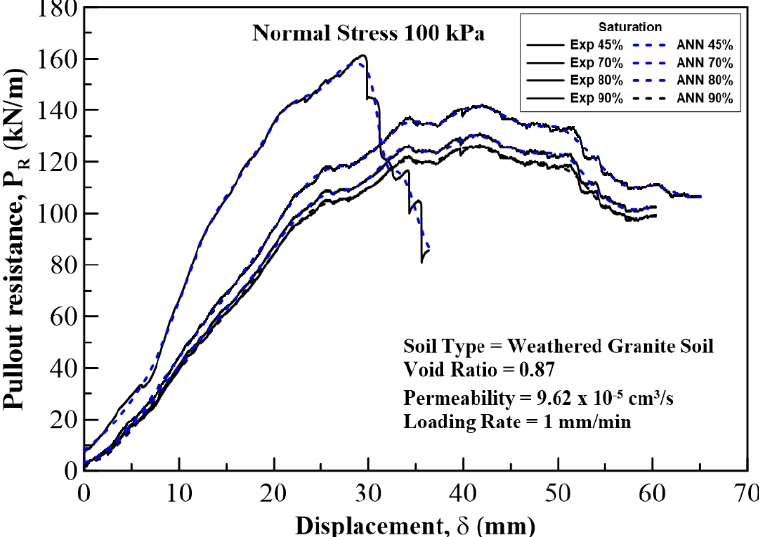
Figure 12. Pullout resistance vs. displacement curves plotted for a normal stress of 100 kPa at 45%, 70%, 80%, and 90% degree of saturation of the soil. Solid lines show experimental results, and the dotted lines show ANN results.